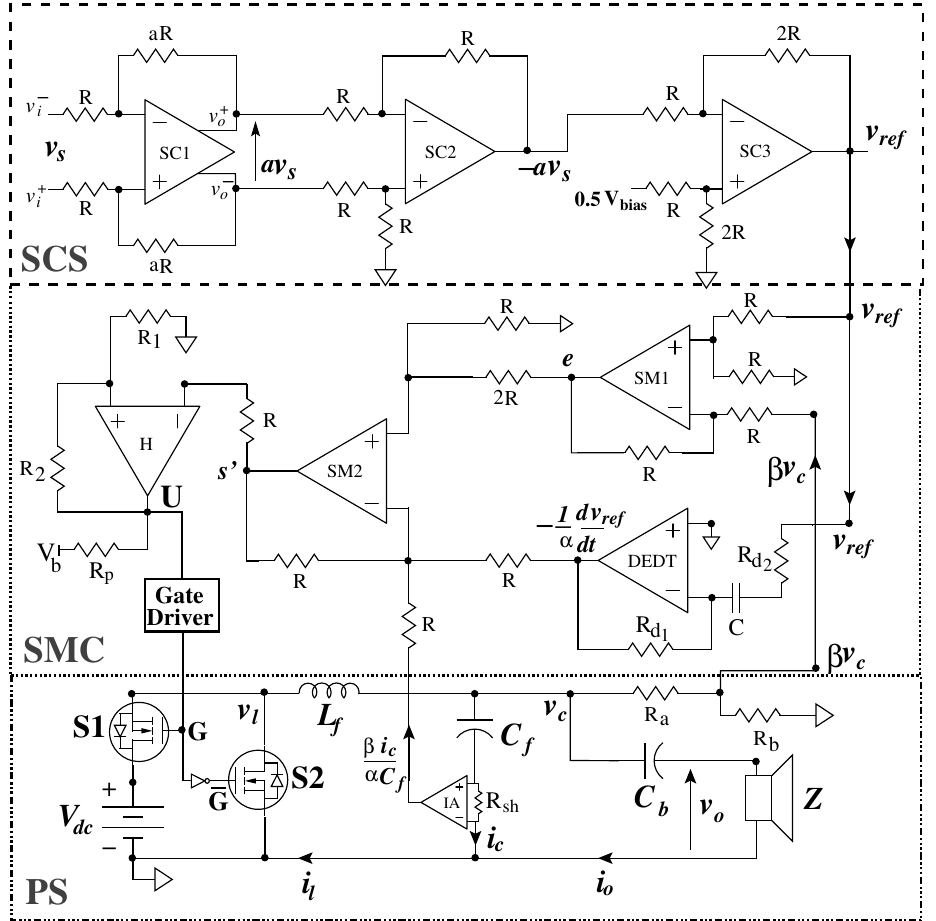
Figure 9. Control scheme of the audio